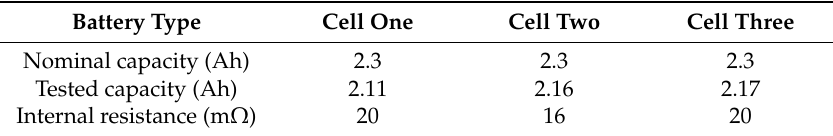
Table 2. Specification of three LiFePO 4 battery cells in the pack.